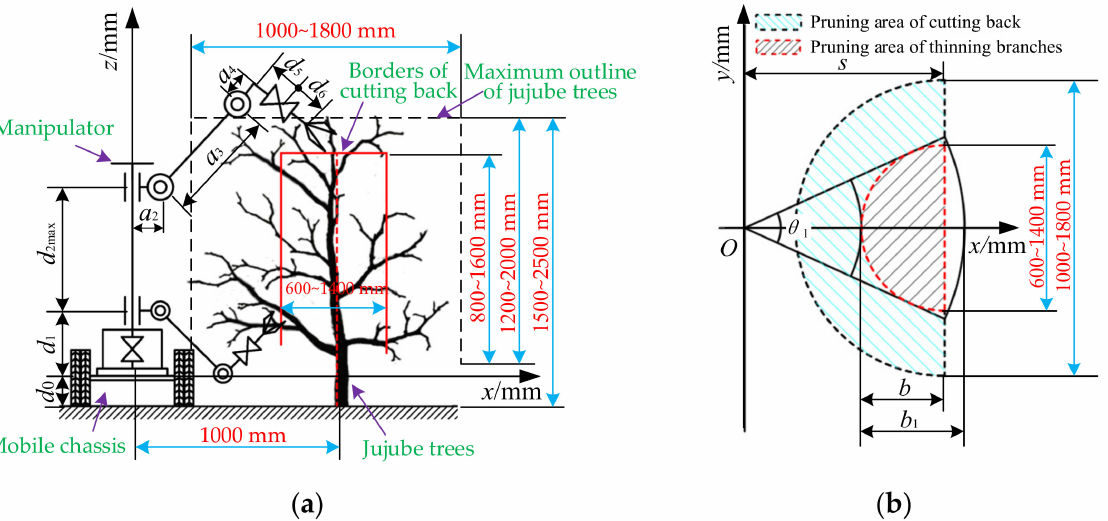
Figure 3. Schematic diagram of the pruning space analysis for the manipulator. ( a ) Main view; ( b ) top view. Note: d 0 is the distance between the base of the manipulator and the ground, mm; d 1 is the height of the base, mm; d 2max is the maximum travel of the machine body, mm; a 2 is the offset of the shoulder joint, mm; a 3 is the length of the big arm, mm; a 4 is the offset for the rotatory joint of the forearm, mm; d 5 , d 6 is the length of the forearm, mm; θ 1 is the rotation angle of the base, degree; b is the radius of the jujube canopy after pruning by shortening the branches, mm; and b 1 is the operating width of the manipulator for pruning by thinning the branches,